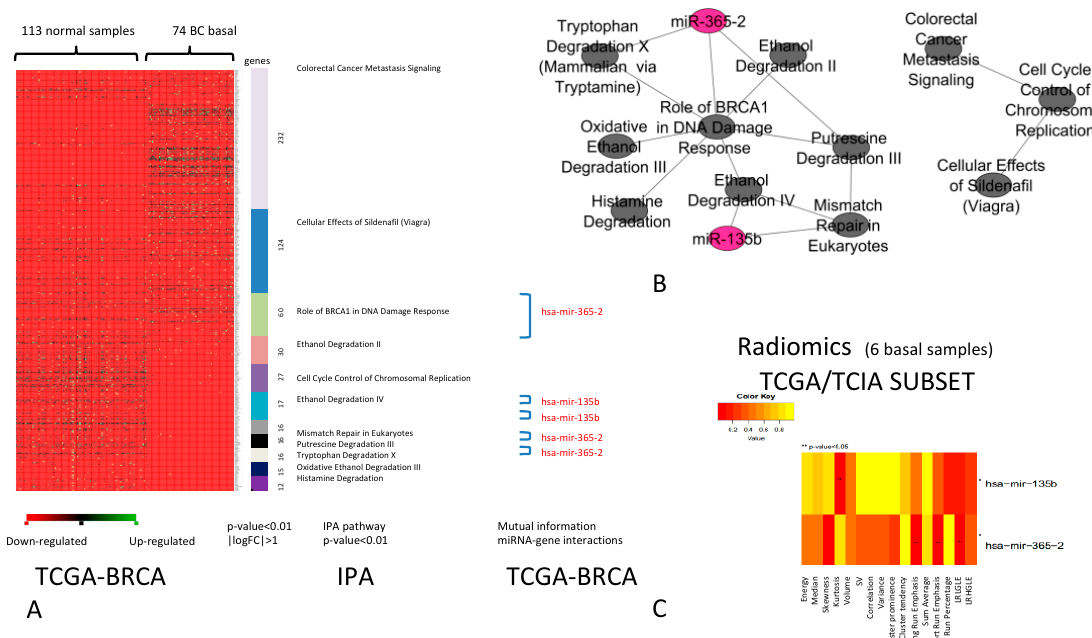
Figure 4. BC Basal. ( A ) The pathways able to classify basal BC vs. normal samples ( p -value < 0.01, |logFC| > 1). For each pathway (in different colours), miRNAs (in red) able to regulate DEGs are indicated. ( B ) Relationships between pathways and miRNAs (the green nodes are the pathways and purple nodes are the miRNAs). ( C ) Heatmap of the correlation between imaging features and miRNAs. The color intensity in the figure shows the corresponding p-value; yellow cells indicate greater statistical significance.